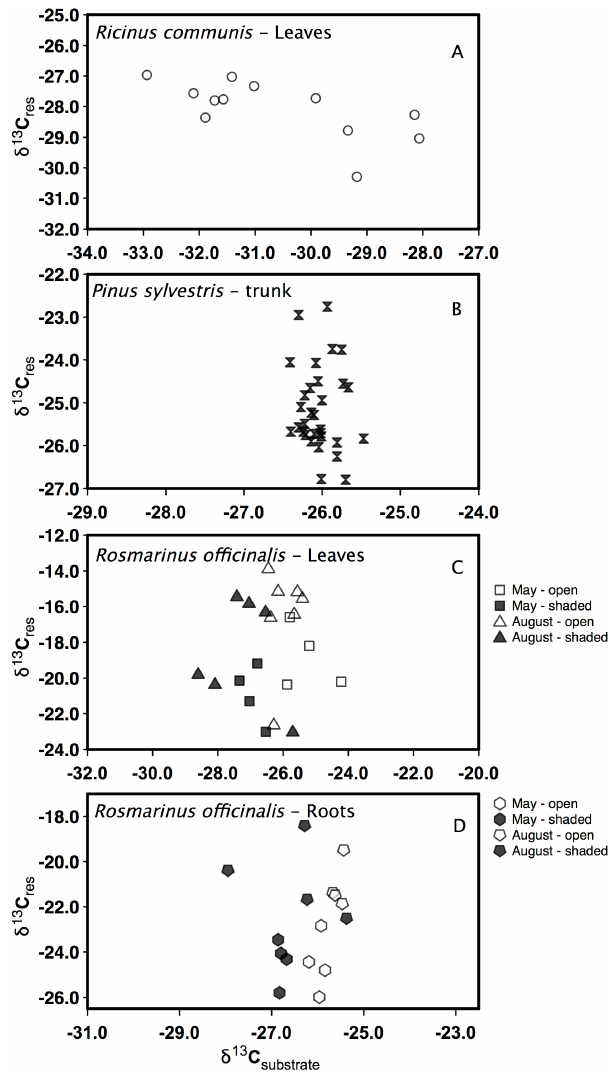
Table 3. Potential mechanisms causing diel variation in δ 13 C res at the plant scale.